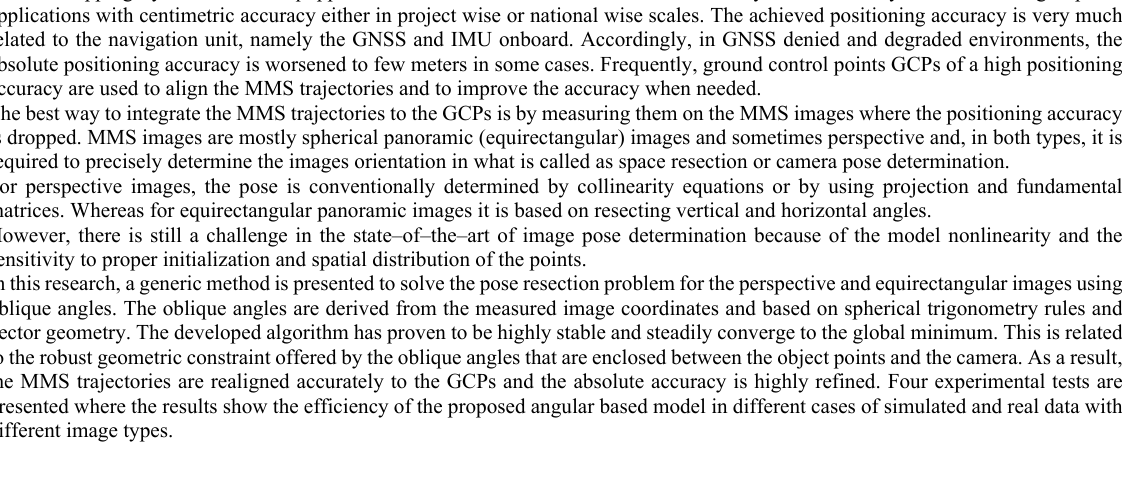
is exactly twice the height. This is logical, since it covers 360  horizontally and 180° vertically and allowing the viewer to look in every direction, including the zenith and nadir (Figure 1).